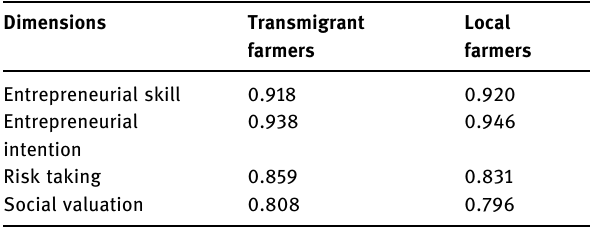
Table 3: The value of reliability by Cronbach